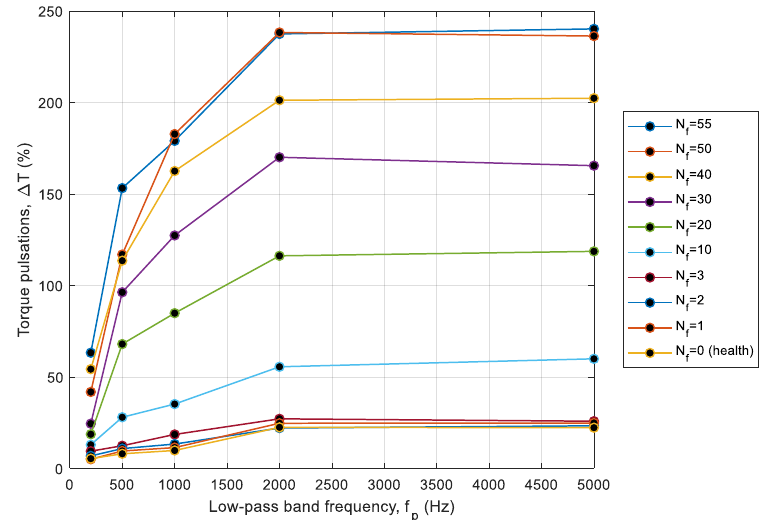
Figure 18. Torque ripple factor as a function of low-pass filter frequency fp in the case of a faulty motor, at T L = 15 Nm.